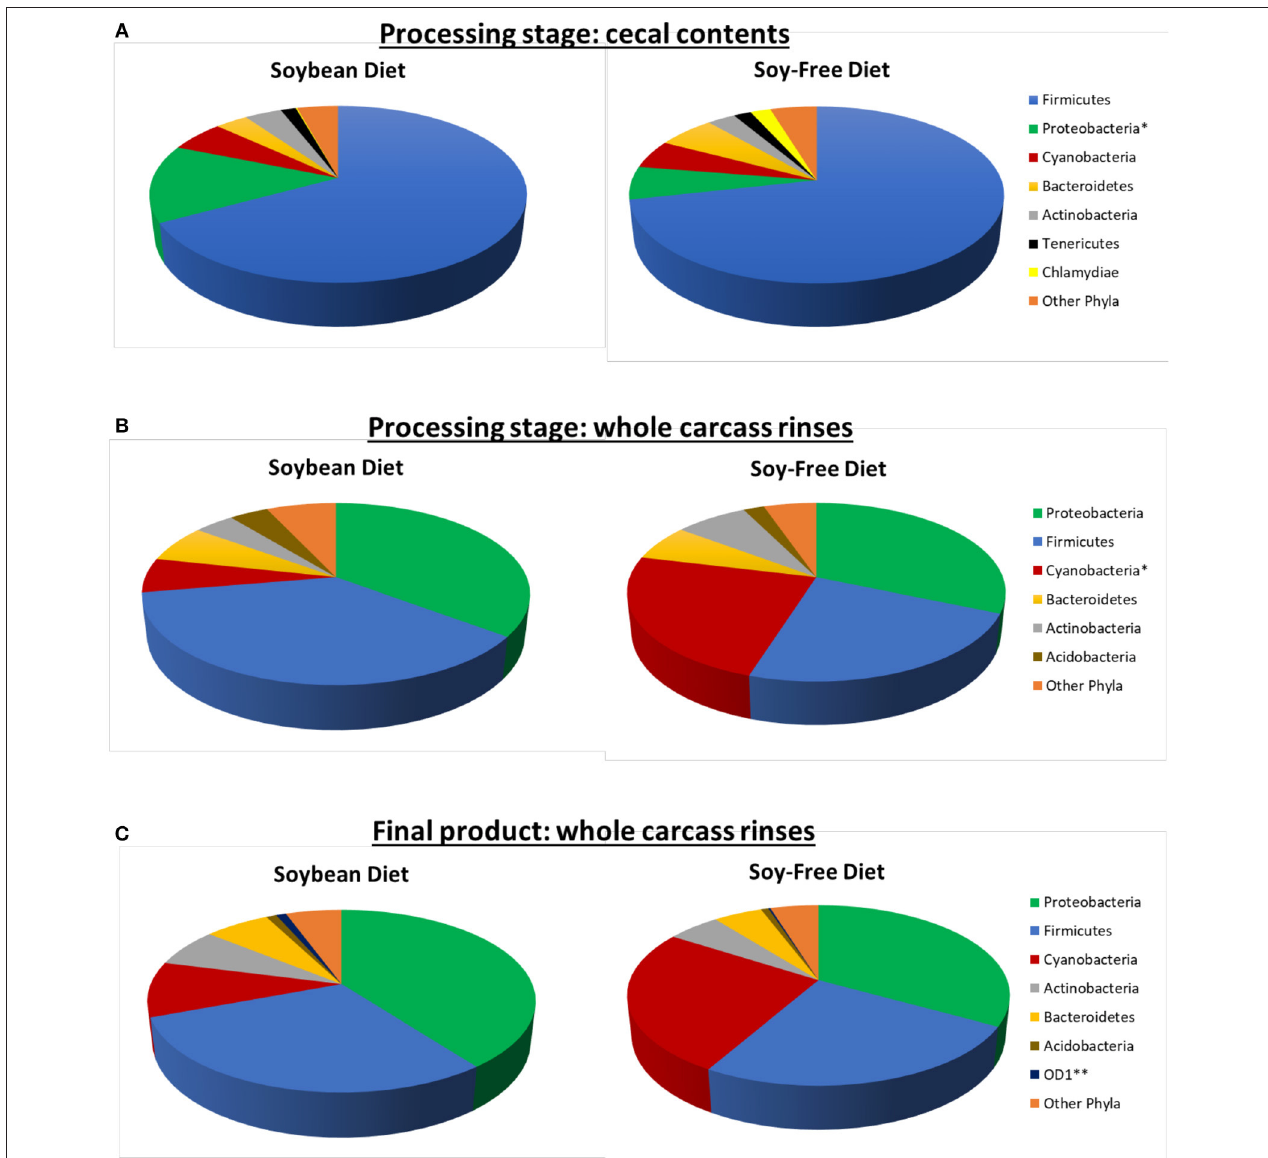
FIGURE 2 | Relative abundance of major bacterial phyla ( ≥ 0.5% of all OTUs recovered) of pasture-raised broilers fed Soybean or Soy-Free Diets, at different stages along the farm-to-fork continuum . (A) Cecal samples obtained during the processing stage; (B) Whole carcass rinses obtained during the processing stage; (C) Whole carcass rinses obtained on the final product. * Differences were significant at the P ≤ 0.05 level. ** Differences were significant at the P ≤ 0.001 level.